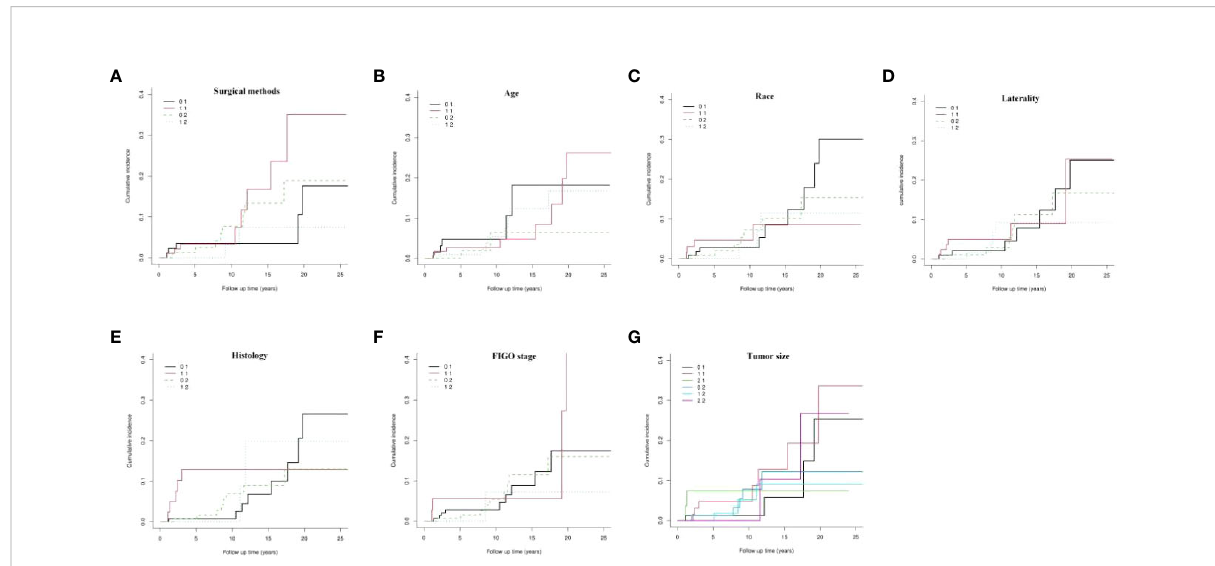
FIGURE 3 Cumulative incidence of death in two end events. FIGO, International Federation of Gynecology and